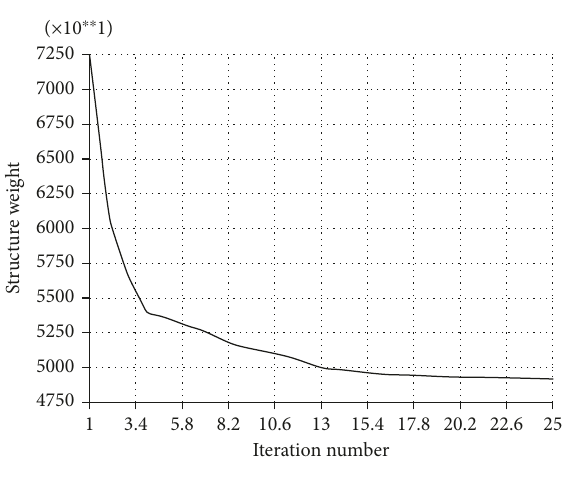
Figure 21: The objective function